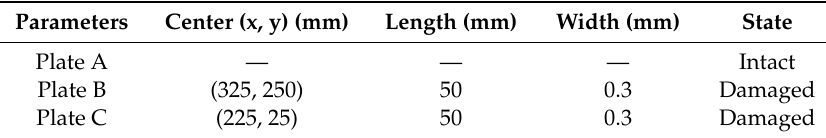
Figure 8. The distribution of artificial cracks: ( a ) Plate B, ( b ) Plate C Table 2. Location of artificial cracks in the three plate specimens.